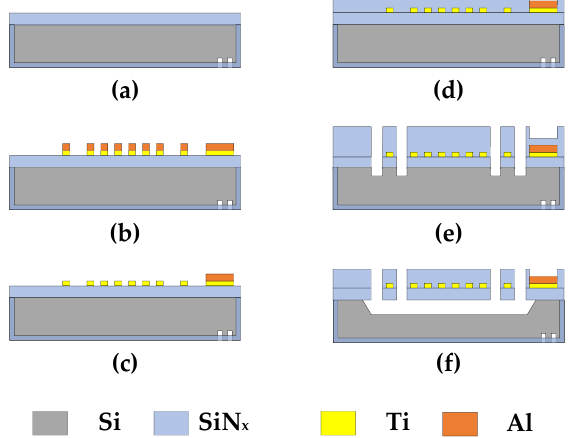
Figure 6. Main steps of the fabrication flow of the designed MEMS Pirani gauge. ( a ) Double-sided deposition of SiN x ; ( b ) Metal layer pattern formation; ( c ) Wet etching of Al to form the pads; ( d ) Deposition and dry etching of SiN x ; ( e ) Dry etching of SiN x and Si to form the cavity release win- dows; ( f ) Cavity formation by KOH etching of Si and pad exposure by blanket etching of SiN x .